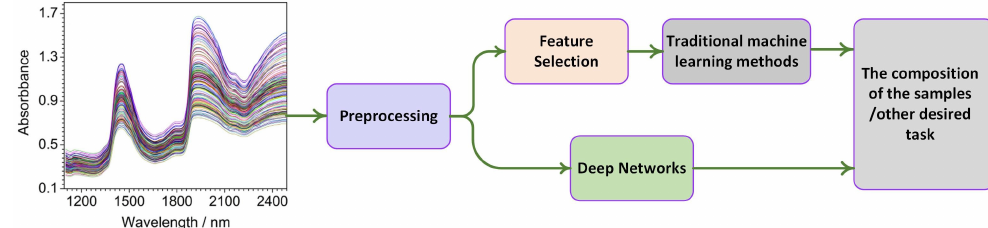
Figure 2. Architecture of machine learning for NIR